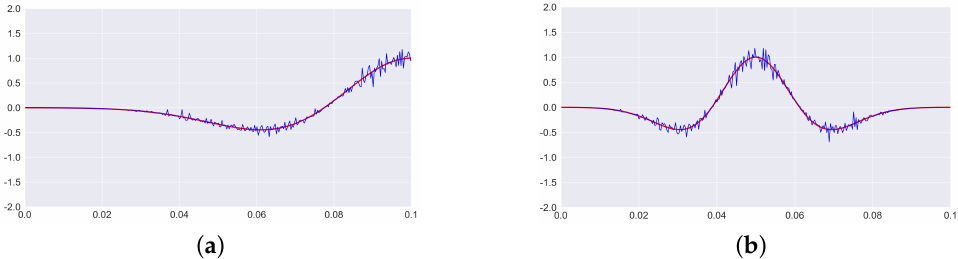
Figure 1. Test 1. Inverse problem I. Reconstruction result after 2000 iterations (Exact data).